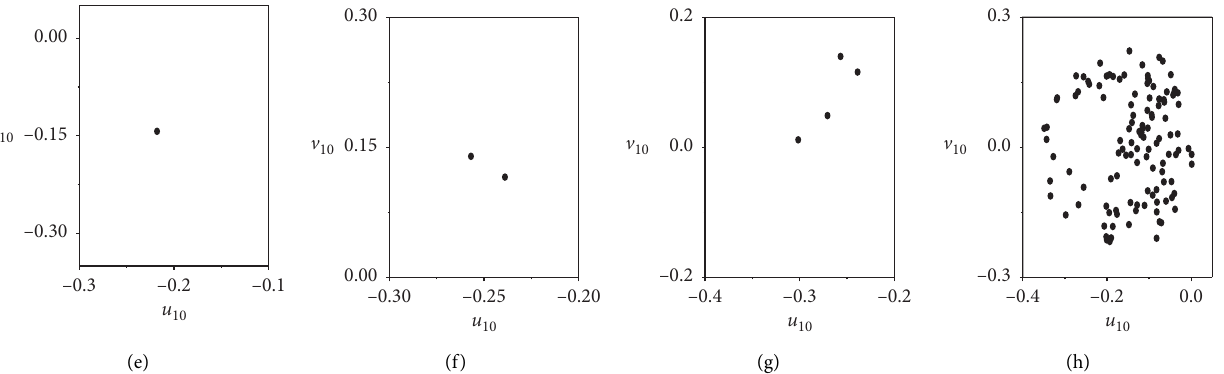
Figure 10: Phase portraits and Poincare maps of the dynamic solutions onto the u � 0 . 05634 (4P); (d, h) σ (2P); (c, g) σ 2